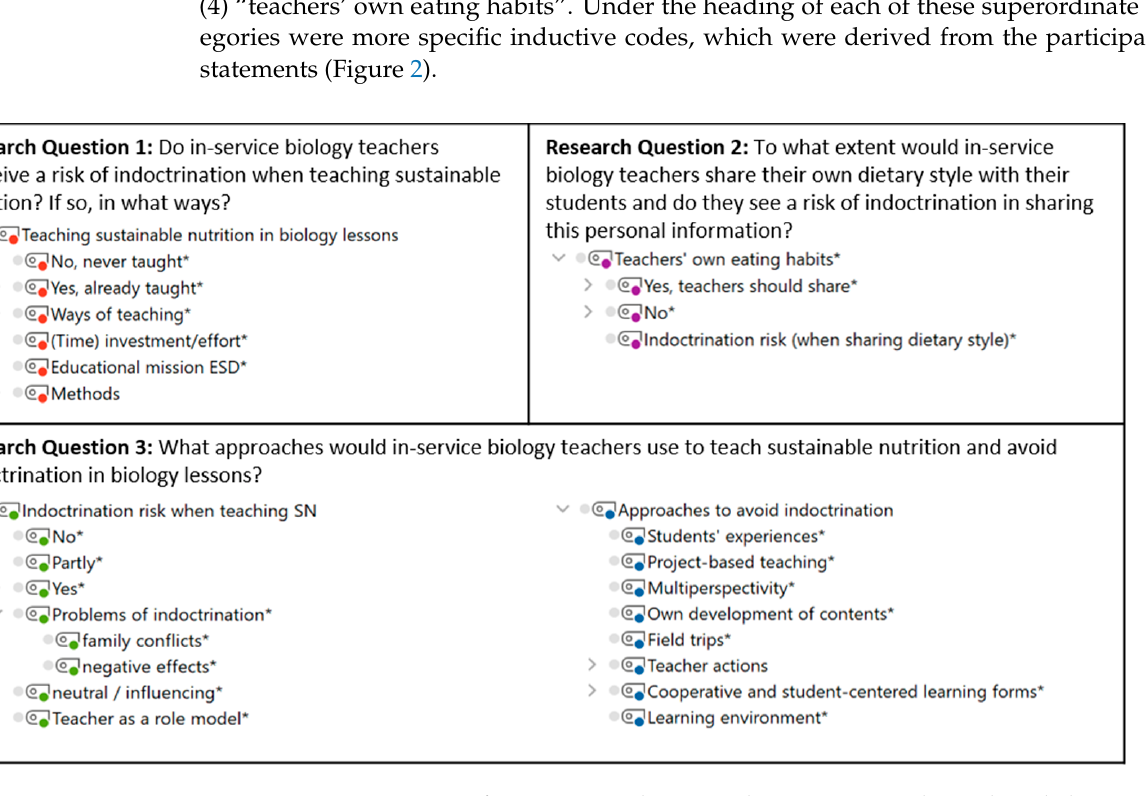
Figure 2. Category Systems for Answering the Research Questions. * Inductively coded categories. ESD = education for sustainable development; SN = sustainable nutrition.